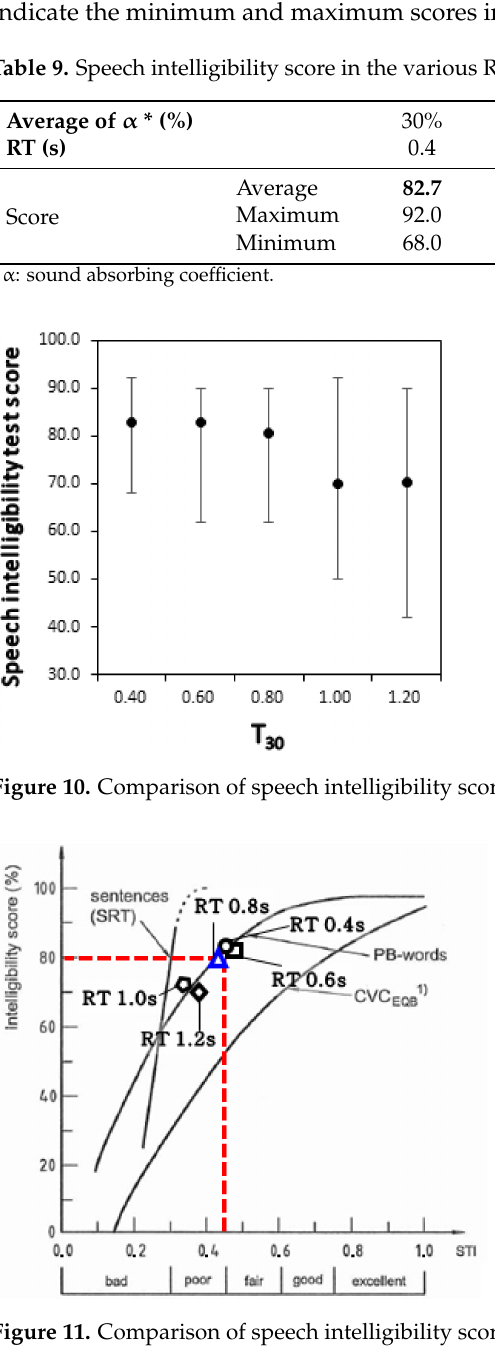
Figure 11. Comparison of speech intelligibility score and STI with perception of